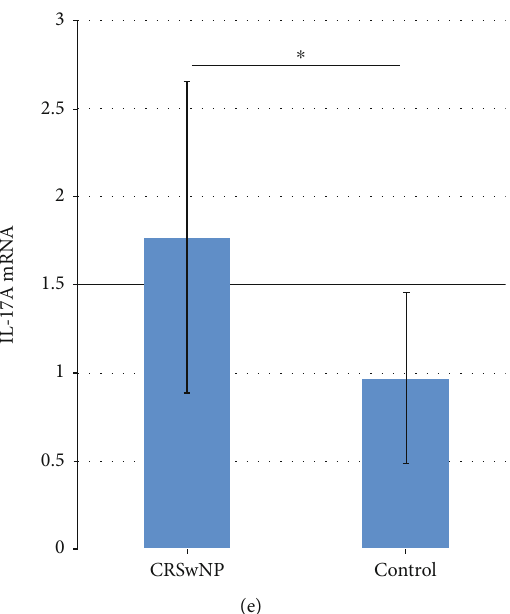
Figure 1: The levels of in fl ammatory indicators in serum and nasal polyps in di ff erent groups. (a) By the UniCAP100 system, the serum levels of total IgE did not signi fi cantly di ff er between CRSwNP patients and controls. P = 0 : 451 . (b) By the UniCAP100 system, the serum ECP levels did not signi fi cantly di ff er between CRSwNP patients and controls. P = 0 : 058 . (c) By ELISAs, the total IgE and ECP levels in nasal polyp supernatants of CRSwNP patients were not signi fi cantly di ff erent from those observed in control. P = 0 : 547 and 0 : 132 . (d) By the biochemical method, the enzyme activity of MPO in nasal polyps of CRSwNP patients was higher than that in control tissues. P < 0 : 001 . (e) By RT-PCR, the level of IL-17A mRNA in nasal polyps of CRSwNP patients was signi fi cantly increased, compared with control tissues. P = 0 : 049 . ∗ P < 0 : 05 , ∗∗ P < 0 : 001